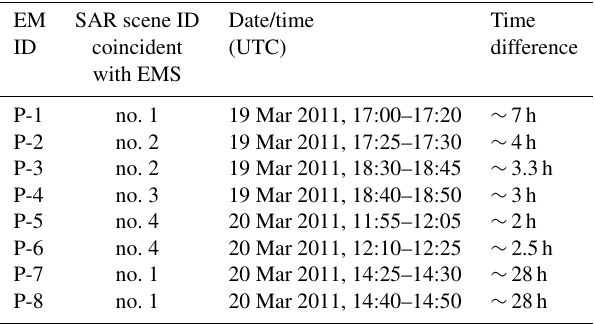
Table 4. Specifications of helicopter-borne EMS ice thickness data sets.